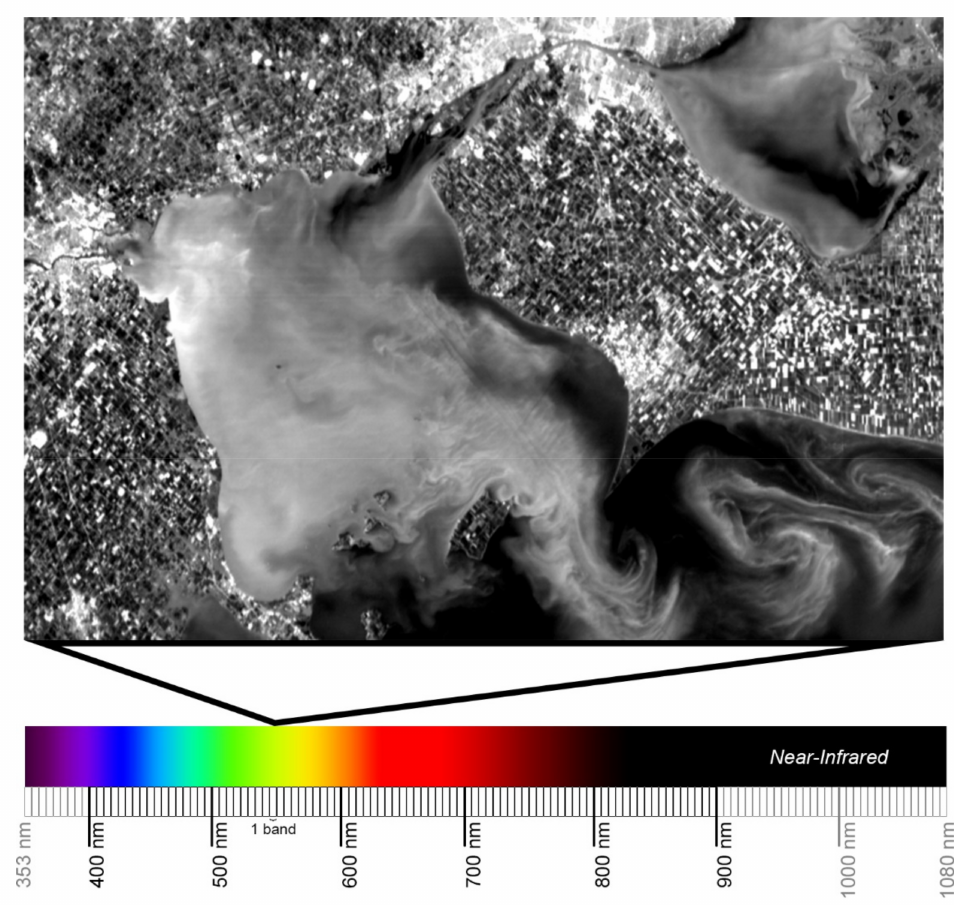
Figure 2. HICO bands on the electromagnetic spectrum and band 36 (553 nm), cut and resized to fit the area of interest, but not oriented. Scene H2011246173456 (Data source: NASA Ocean Color